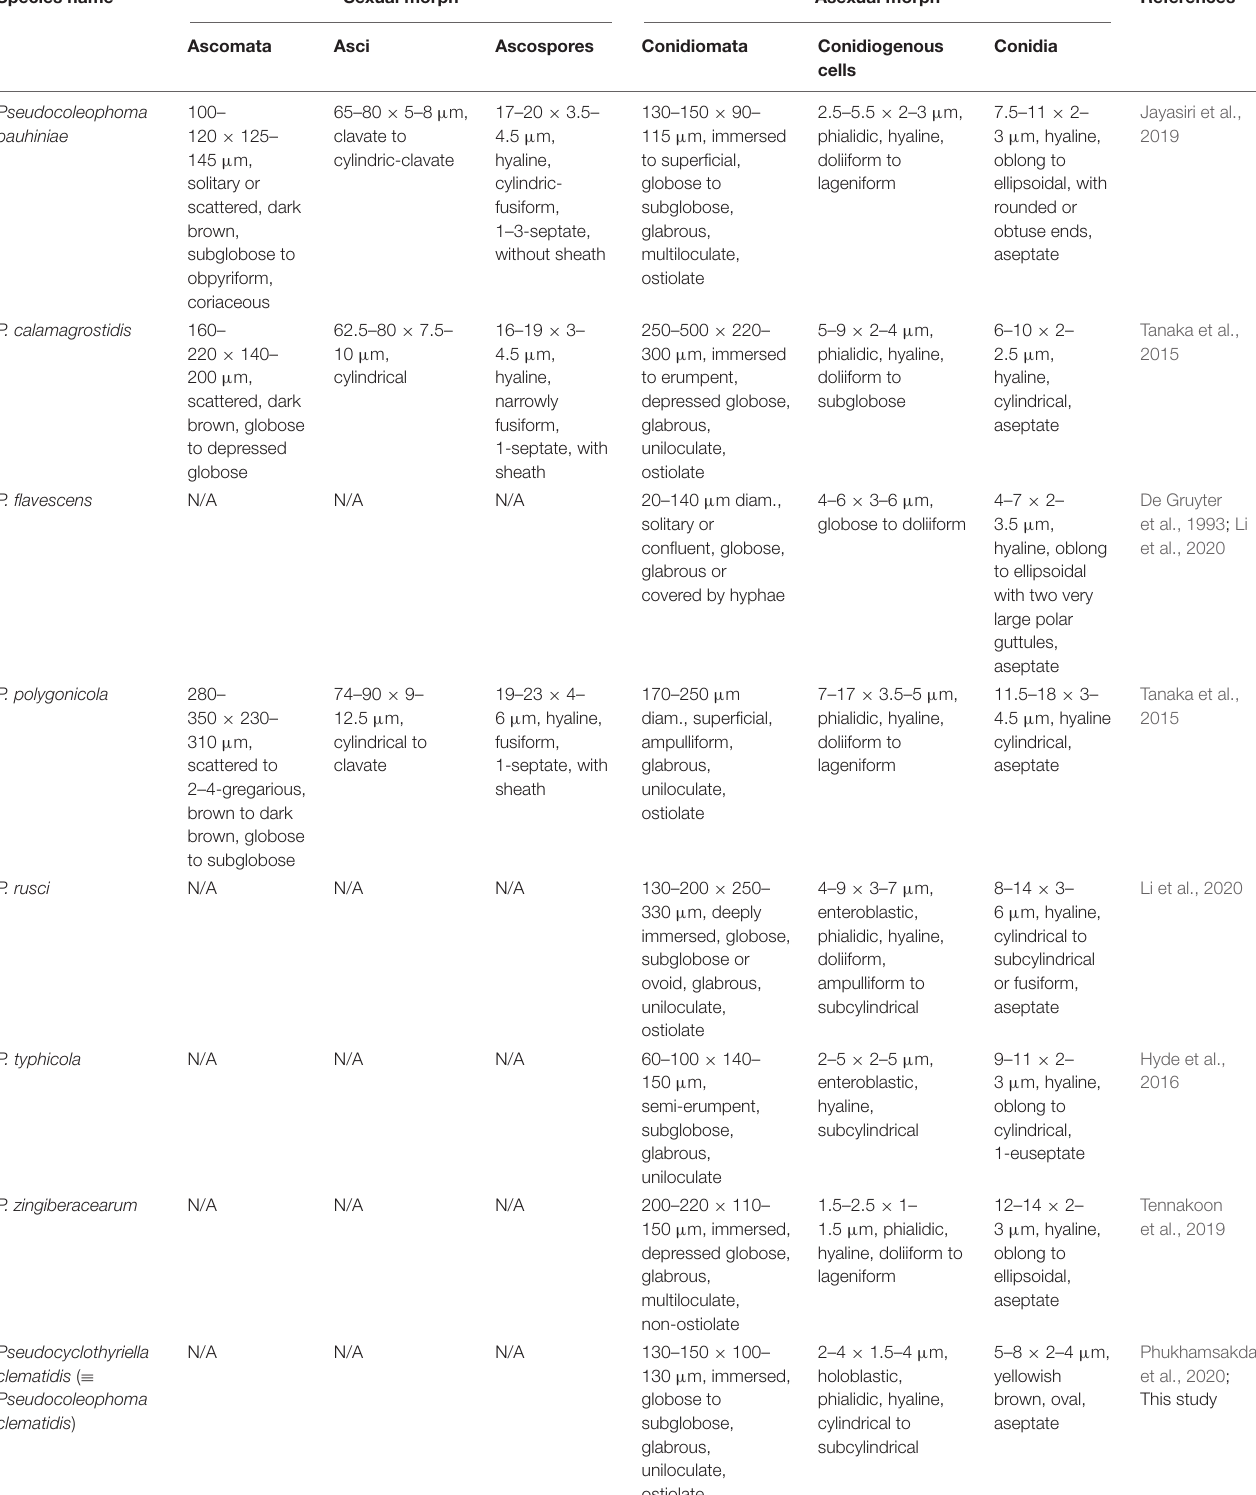
TABLE 3 | Synopsis of morphological characteristics of Pseudocoleophoma and